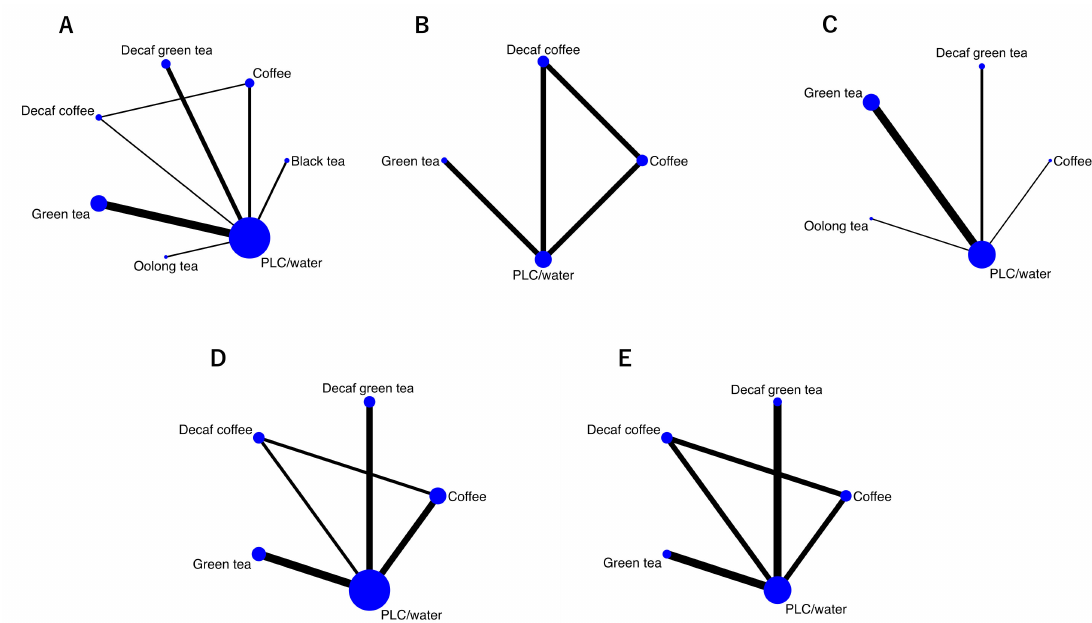
Figure 2. Network maps. ( A ) Fasting blood glucose; ( B ) 2-h post-load glucose concentration from an oral glucose tolerance test; ( C ) HbA1c; ( D ) fasting blood insulin; ( E ) HOMA-IR; Nodes represent the interventions and their sizes represent the number of participants. Edges represent the available direct comparisons between pairs of interventions; the width represents the number of studies comparing the pair of interventions. Abbreviations: Decaf, decaffeinated; PLC,